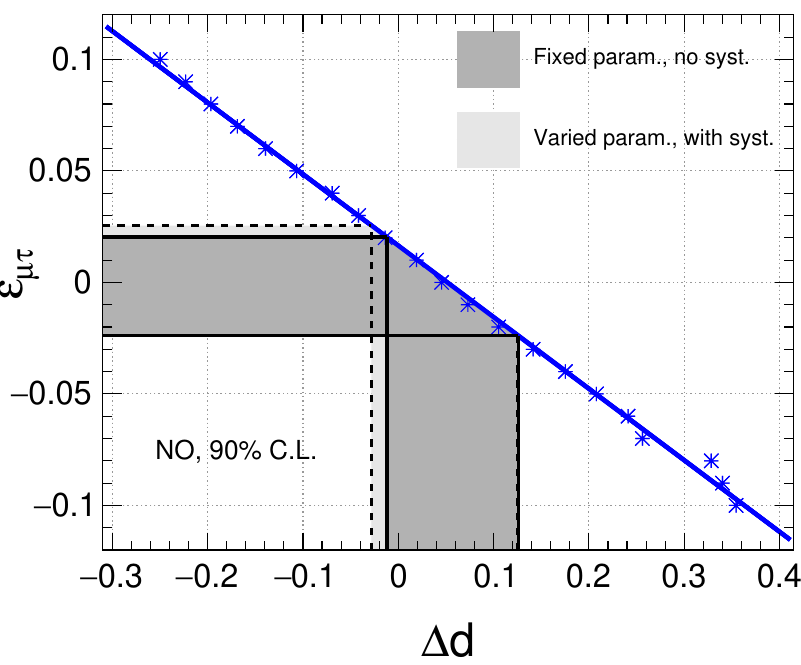
Figure 7 . The blue stars and the blue solid line indicate the calibration curve of ε µτ against ∆ d , obtained using 1000-year MC data with normal mass ordering. The gray bands show the expected 90% C.L. limits on ∆ d (vertical bands), and hence on ε (horizontal bands), with 500 kt · yr of µτ ICAL exposure, when the actual value of ε = 0 . The light (dark) gray bands show the limits µτ when the errors on oscillation parameters, and the impact of systematic uncertainties are included (excluded), as discussed in section 4.2. For fixed-parameter case, we use the benchmark oscillation parameters given in table